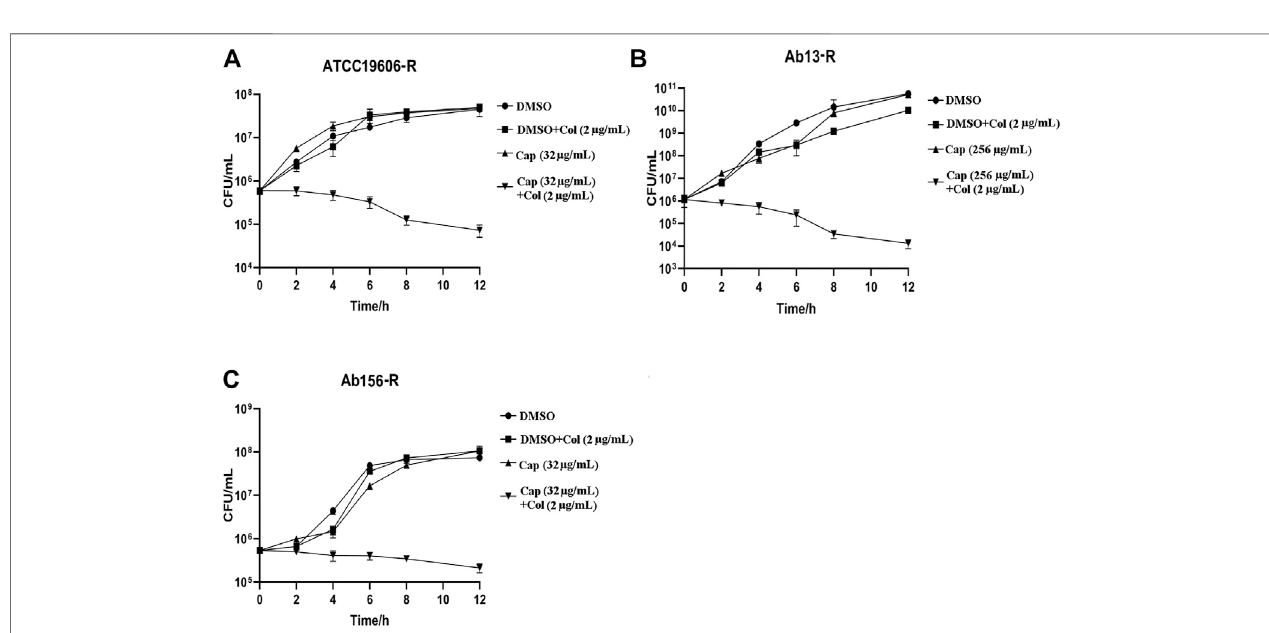
FIGURE1| Time-killcurvesof A.baumannii isolatesusingthedrugsaloneorincombination.ThecapsaicinconcentrationsofATCC19606-R,Ab13-RandAb156- R were 32 μ g/mL, 256 μ g/mL, 32 μ g/mL, respectively; at which the MIC values of colistin are below the susceptibility breakpoint (2 μ g/mL). (A) : Time-kill curves of ATCC19606-R using capsaicin (32 μ g/mL) or colistin (2 μ g/mL) without or with capsaicin (32 μ g/mL). (B) : Time-kill curves of Ab13-R using capsaicin (256 μ g/mL) or colistin(2 μ g/mL)withoutorwithcapsaicin(256 μ g/mL). (C) :Time-killcurves ofAb156-Rusingcapsaicin(32 μ g/mL)orcolistin(2 μ g/mL)withoutorwithcapsaicin (32 μ g/mL). Abbreviations: Cap, capsaicin; Col, colistin; DMSO, dimethyl sulfoxide.